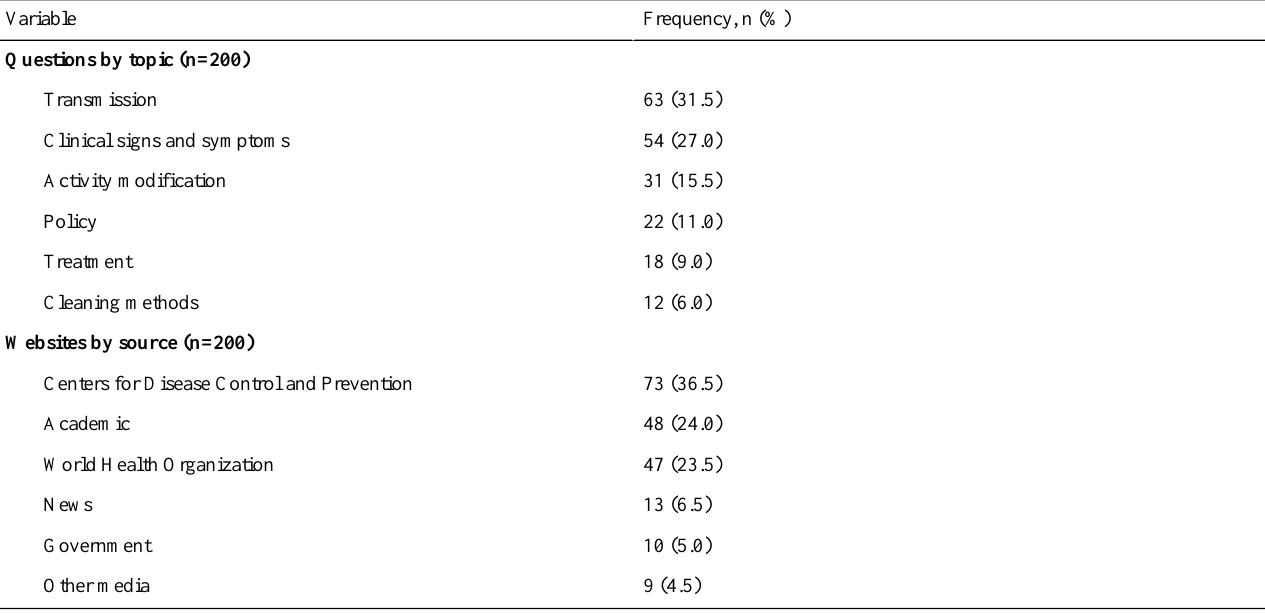
Table 2. Frequencies and percentages associated with questions by topic and websites by